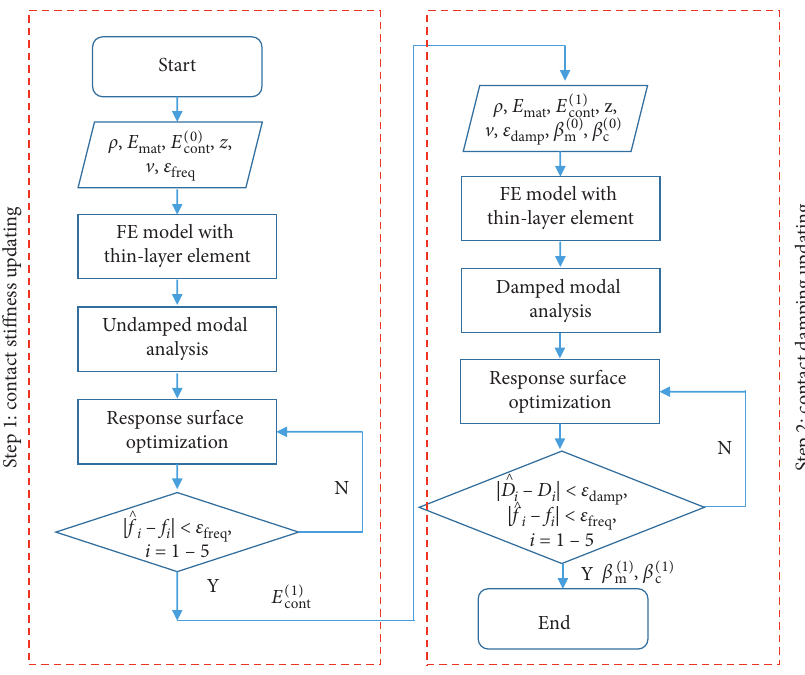
Figure 10: Flowchart of a two-step model updating approach. Table 2: Material property of the tie-bolt rotor.